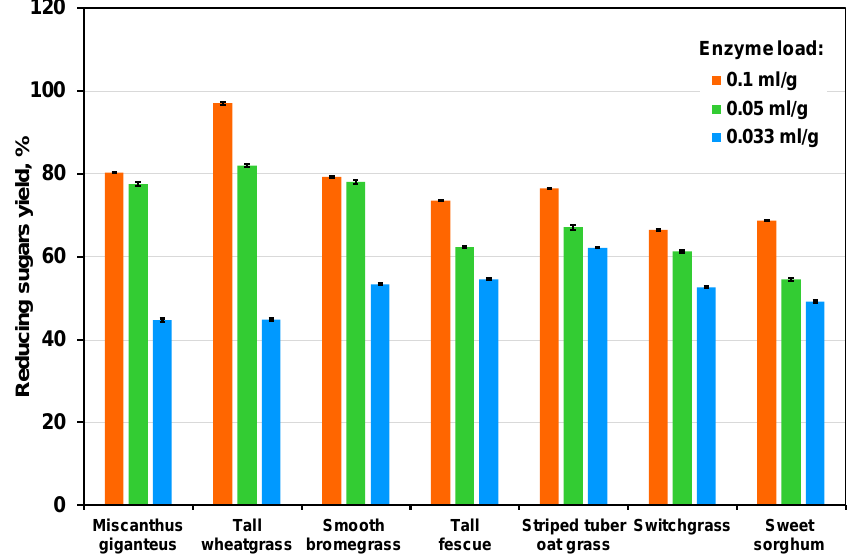
Figure 2. The effect of enzyme concentration on reducing sugars yield from 7 cellulosic pulps of different origins (note: values are the means of triplicate assays). Table 5. The effect of enzyme load on the amounts of insoluble residues that remained after hydrolysis of the kraft pulps.